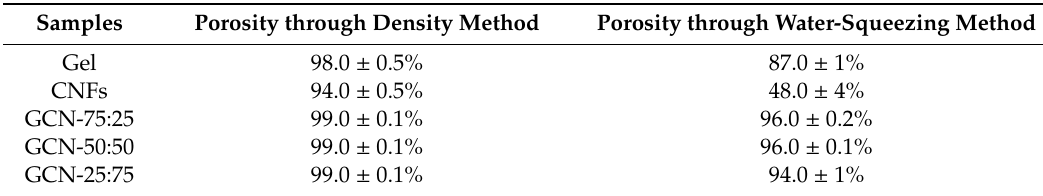
Table 1. Summary of porosity for the Gel–CNF biocomposites.